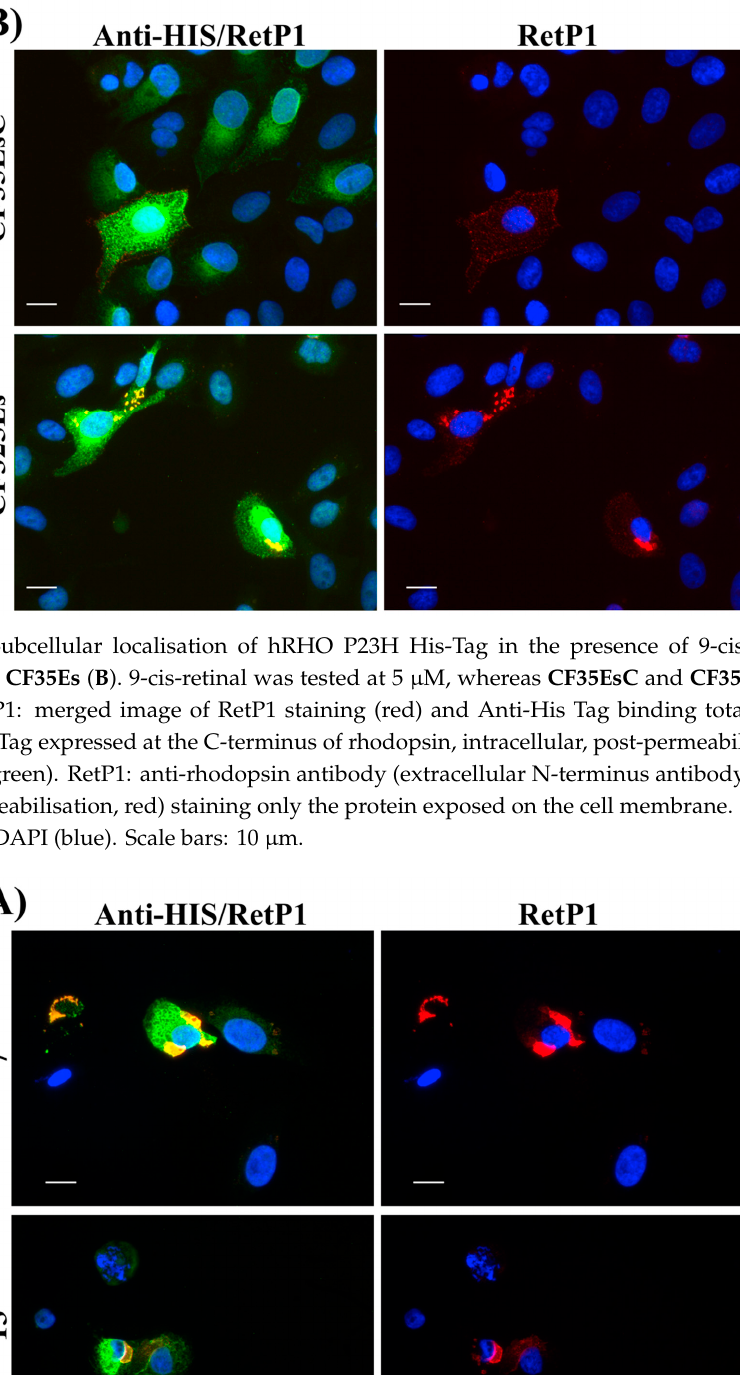
Figure 17. Subcellular localisation of hRHO P23H His-Tag in the presence of tested compounds: 7 and 13 ( A ); 20 and 23 ( B ). 13 and 20 were tested at 10 µM, whereas 7 and 23 at 20 µM. Anti-His/RetP1: Merged image of RetP1 staining (red) and Anti-His Tag binding total rhodopsin staining (His Tag expressed at the C-terminus of rhodopsin, intracellular, post-permeabilisation with 0.1% Triton; green). RetP1: Anti-rhodopsin antibody (extracellular N-terminus antibody, incubation prior permeabilisation, red) staining only the protein exposed on the cell membrane. Nuclei were stained with DAPI (blue). Scale bars: 10 µm.